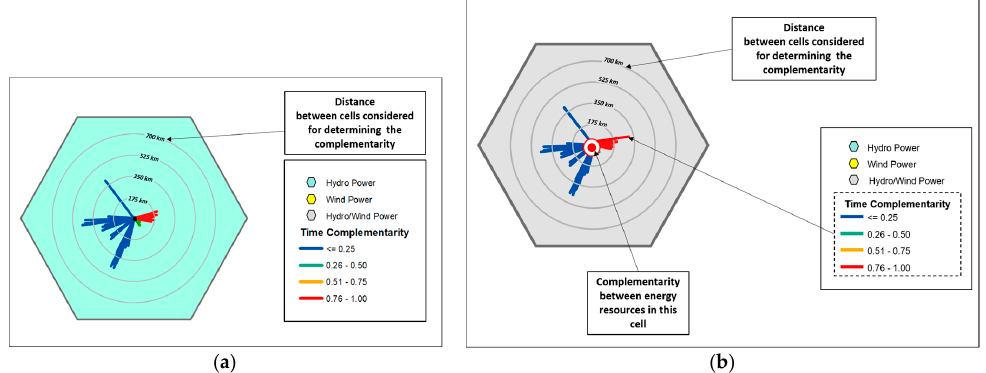
Figure 5. Models for determining roses of complementarity: ( a ) with only one energy resource per cell and ( b ) with two or more energy resources per cell.